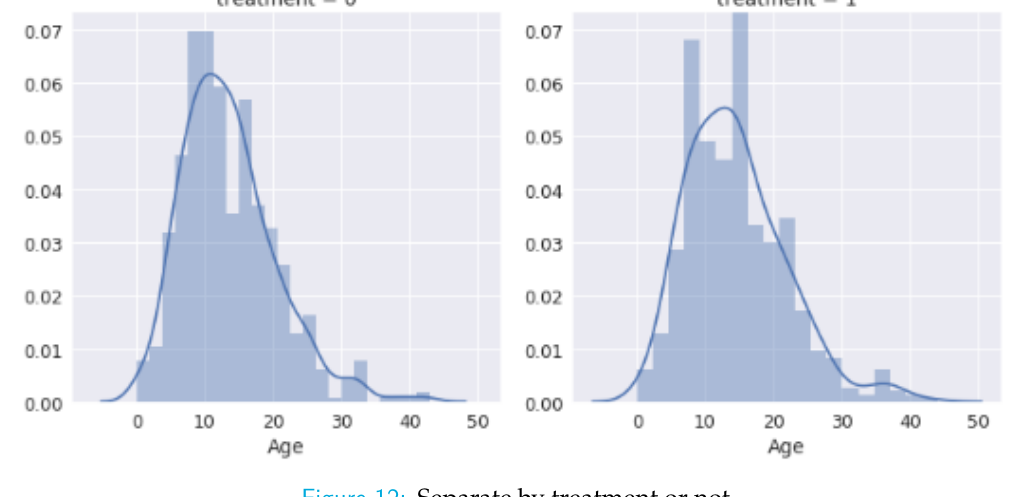
Figure 12: Separate by treatment or not